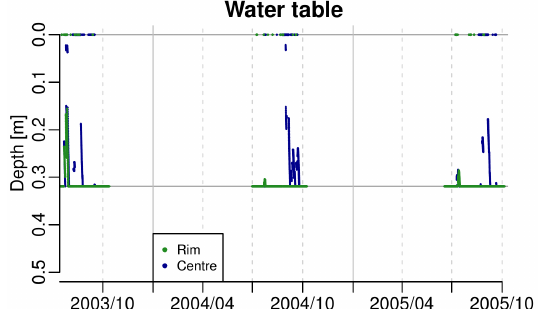
Figure 2. Modelled methane flux out of soil at the rim, centre and a mixed approach of 65% rim plus 35% centre, split into summer and winter. Summer means less than 5cm of snow are on the ground; winter is the remainder. Because of the wide spread of values, from − 0 . 0747mg Cm − 2 h − 1 to as high as 86.8mg Cm − 2 h − 1 , a portion of 4.66% values was cut to provide a reasonable